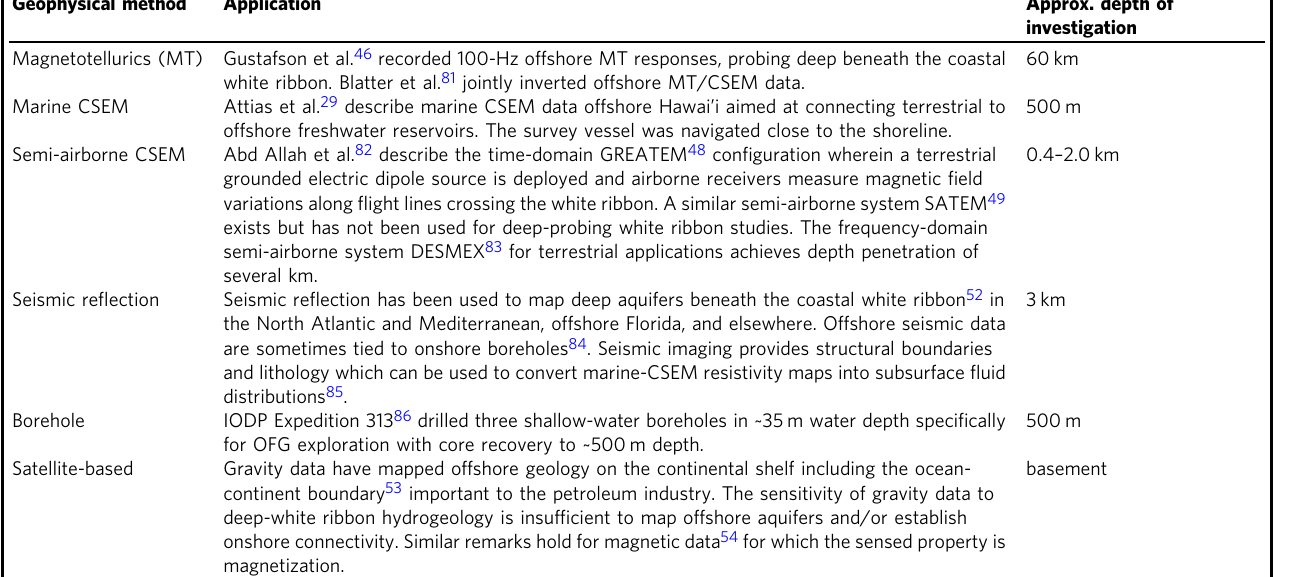
Table 1 Existing geophysical methods for deep onshore-offshore coastal probing along with representative studies. Geophysical